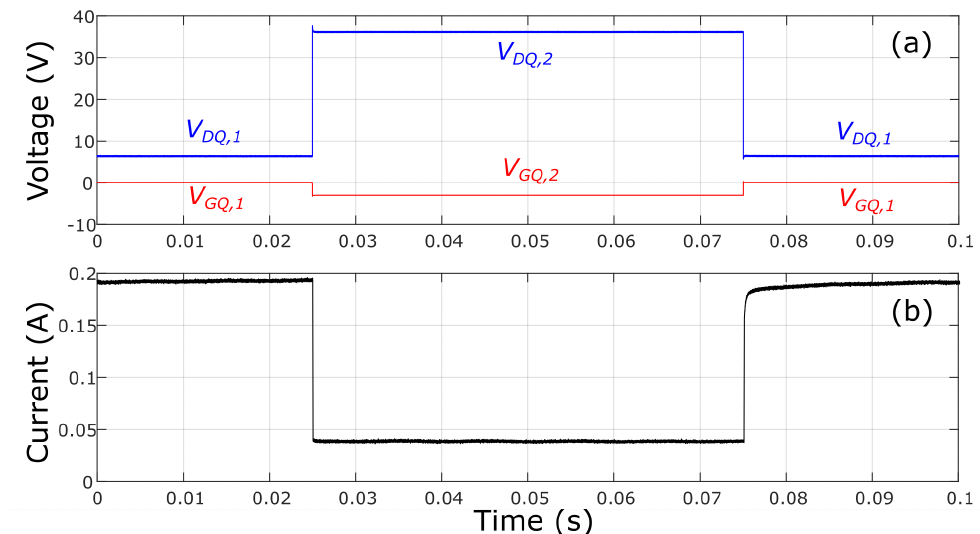
Figure 4. Example of ( b ) current transients acquired for ( a ) 50% duty-cycle voltage excitation applied at both gate and drain port. Each acquisition allows us to evaluate the response to the step-like transition ( V GQ ,1 , V DQ ,1 ) → ( V GQ ,2 , V DQ ,2 ) and the complementary one ( V GQ ,2 , V DQ ,2 ) → ( V ) GQ ,1 , V DQ ,1